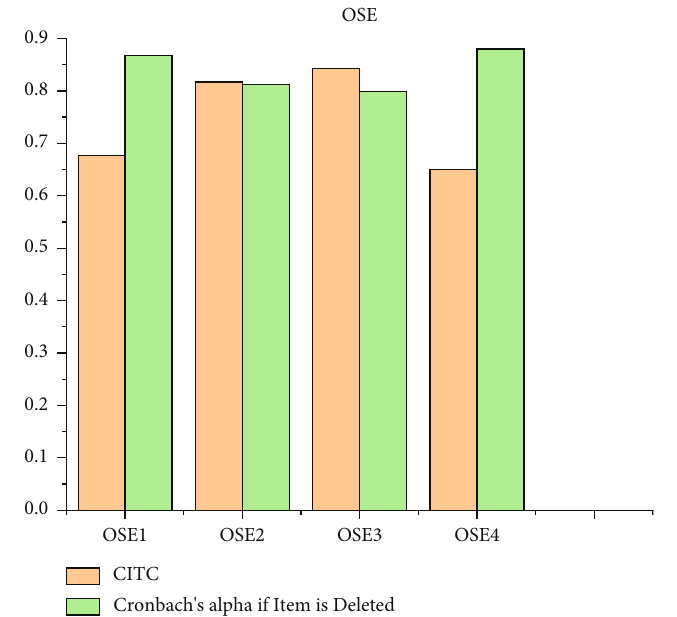
Figure 7: Results of PT analysis.